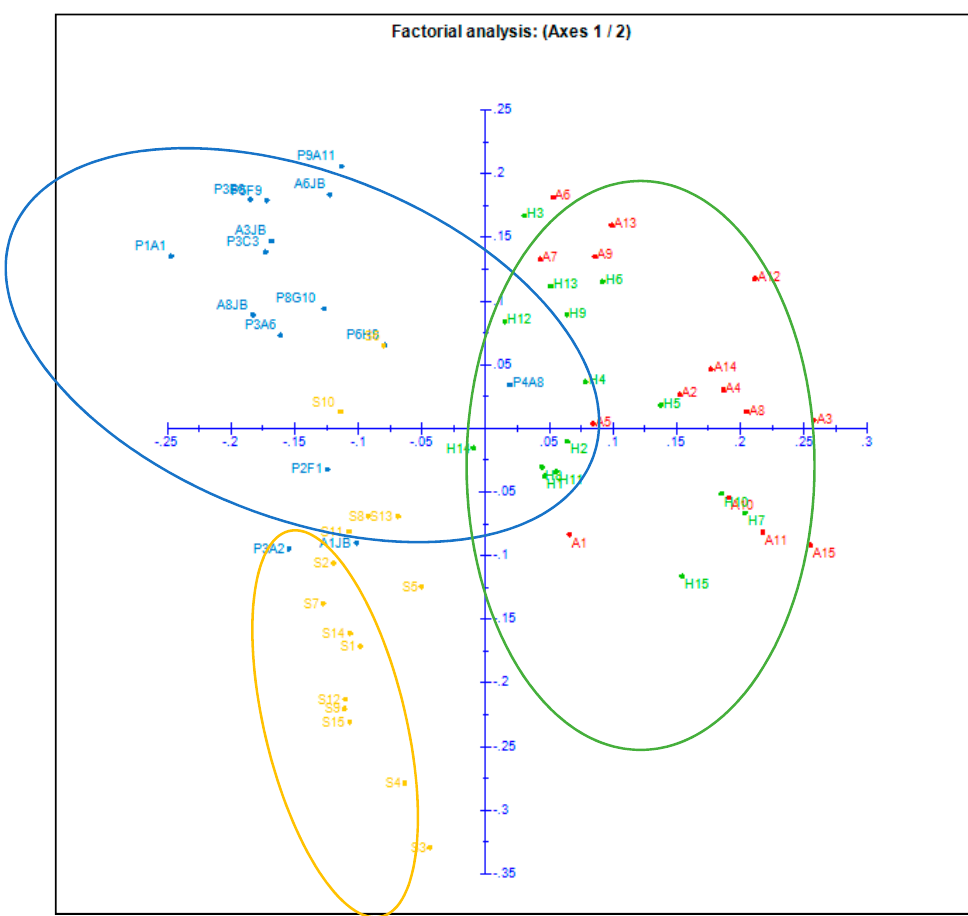
Figure 5. Factorial analysis of different individuals from the four provenances obtained with Darwin software.